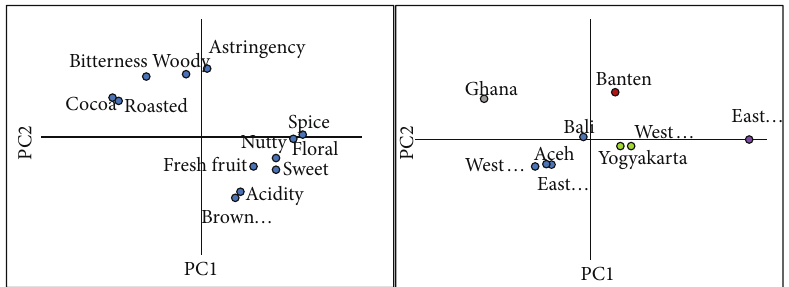
Figure 6: Loading plot (left) and scores plot (right) of principal component analysis on sensory attributes of cocoa bean from Ghana and various regions of